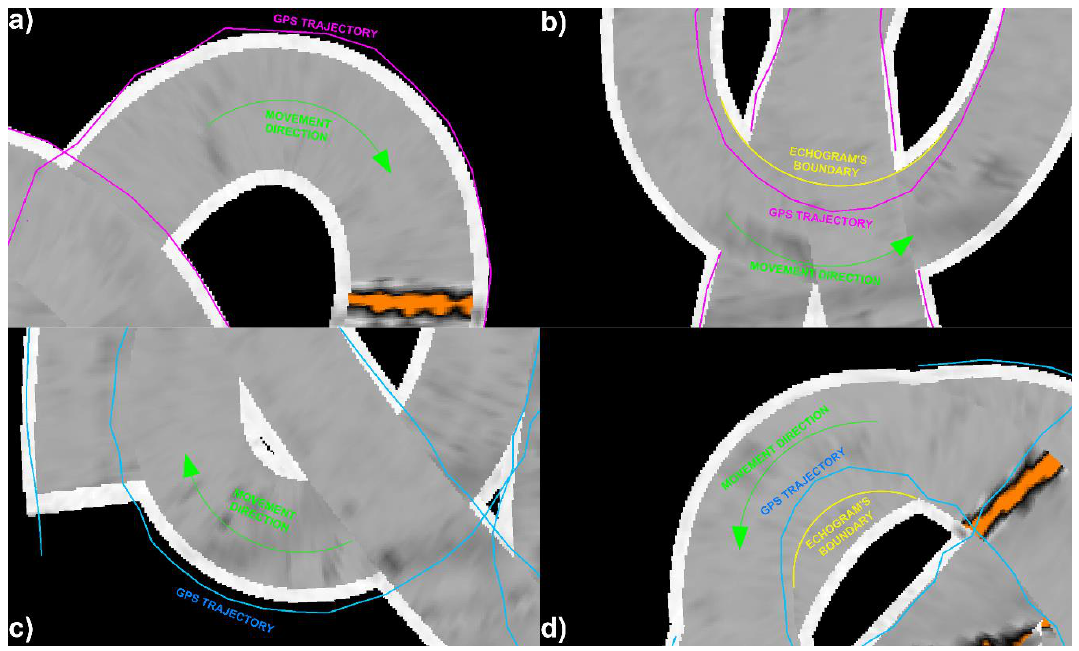
Figure 12. Relation between echogram shape and direction of the turning for positioning using GPS PPS—( a ) right turn, ( b ) left turn—and GPS—( c ) right turn, ( d ) left turn.